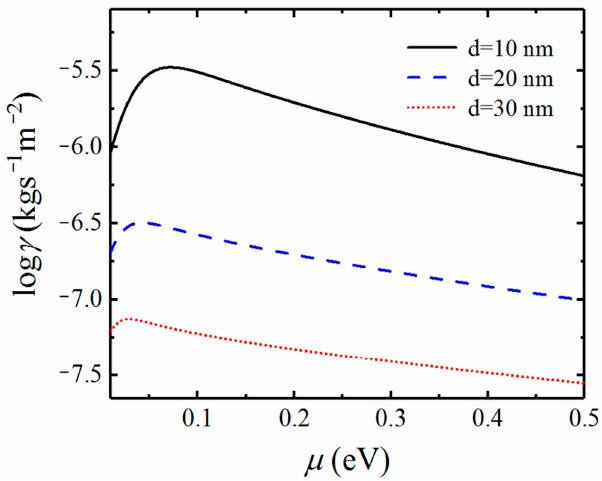
Figure 7. Dependence of the Casimir friction coefficient on chemical potential for different separation distances d .